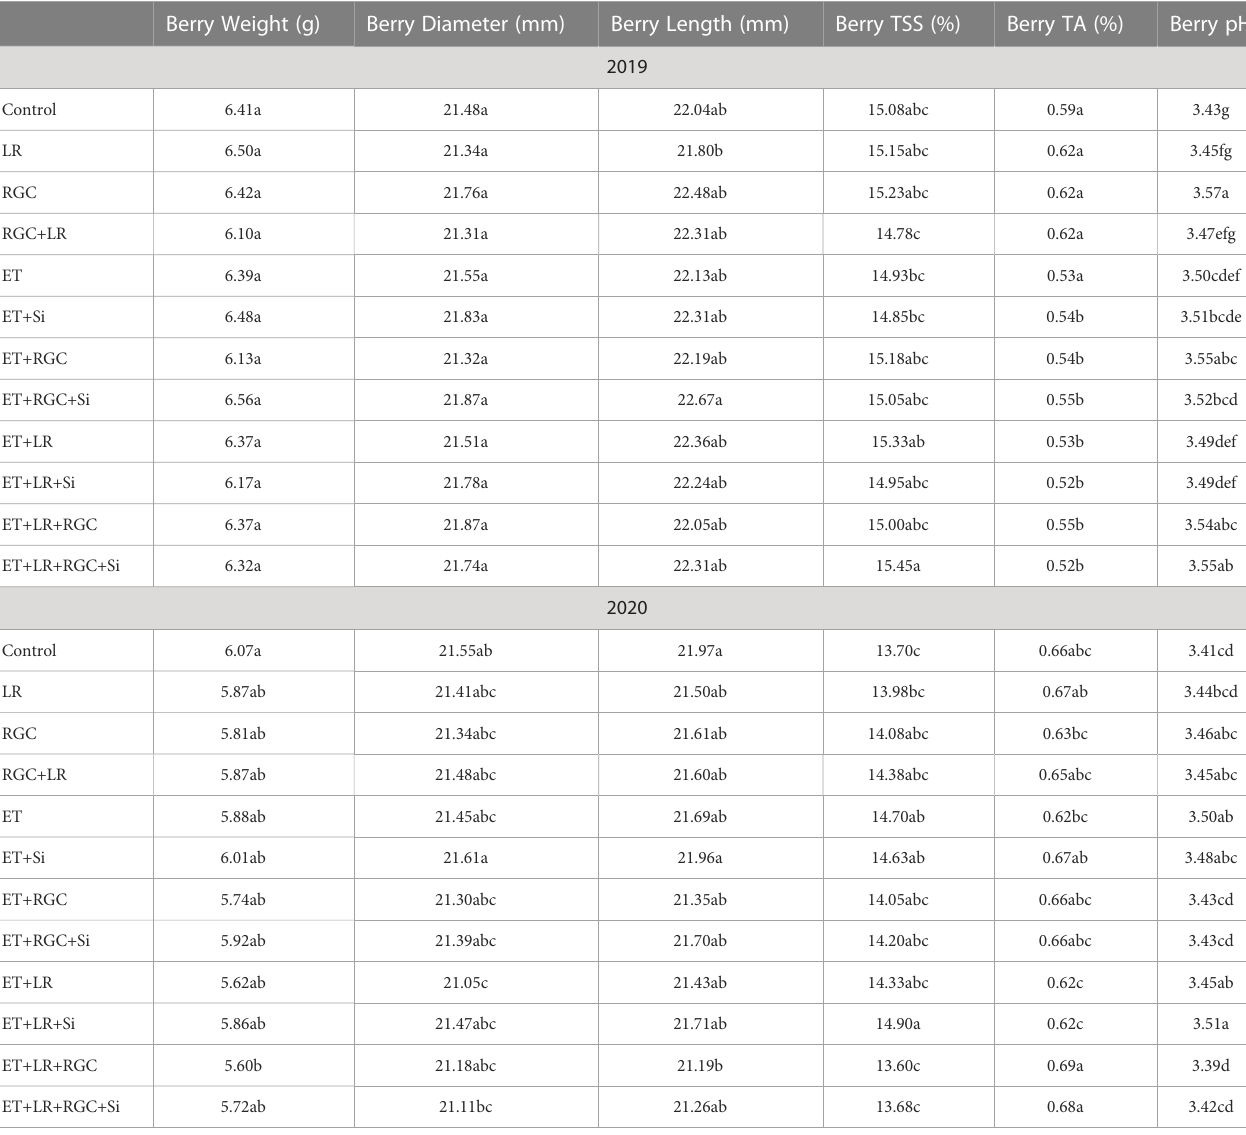
TABLE 3 Berry quality paraments as affected by the different